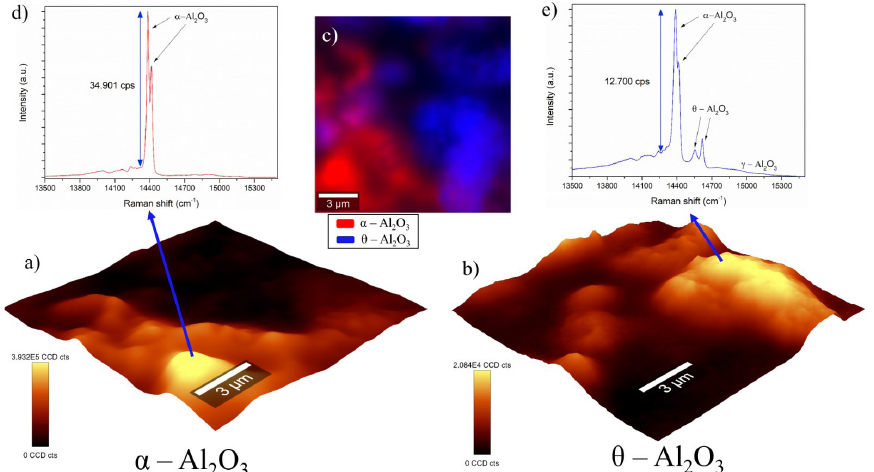
Figure 6. Confocal Raman mapping at the surface of the Pd-modified coating (9.6 µm) after isothermal oxidation at 1000 °C for 200 h: a) mapping in a spectral range from 14,308 to 14,472 cm -1 (α-Al c) mapping showing the distribution of polymorphic forms of Al